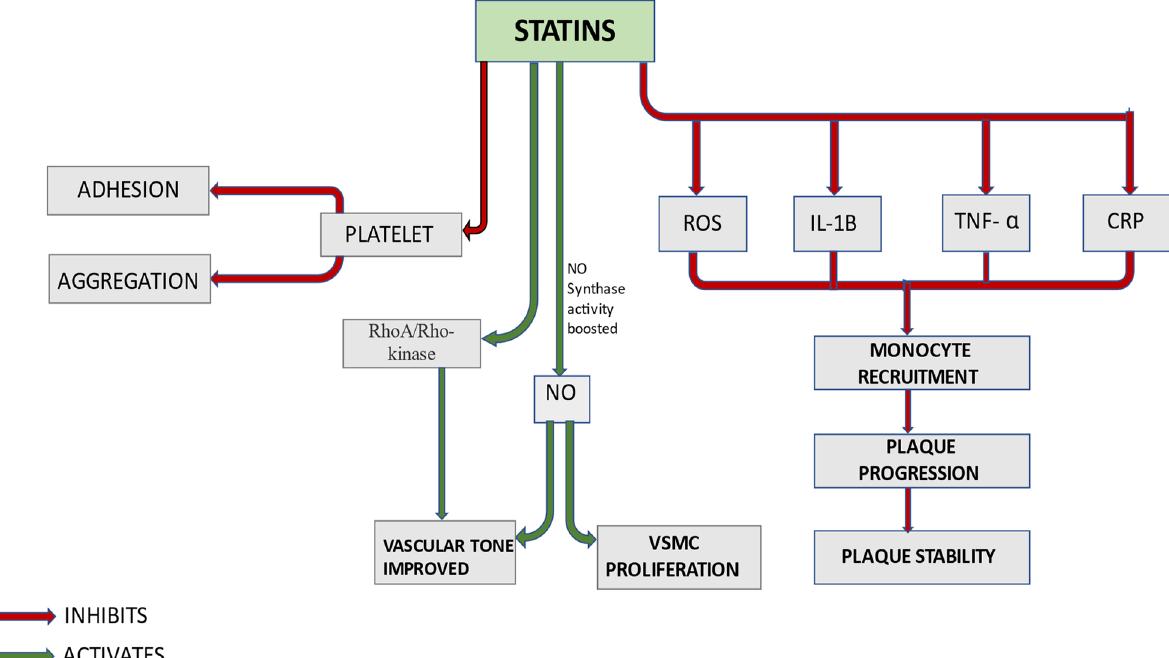
Fig. 2 Role of statins in atherosclerosis ( NO nitric oxide, ROS reactive oxygen species, IL 1B-interleukin 1B, TNF-α tumor necrosis factor α, CRP c reactive protein, VSMC vascular smooth muscle